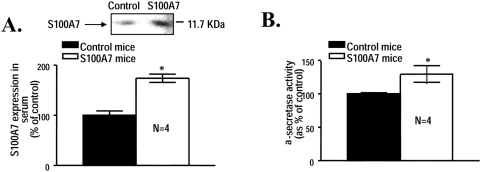
Elevated α-secretase activity in the brain of h-S100A7 transgenic mice.In this study, h-S100A7 transgenic mice were identified by dot blot hybridization of tail skin DNA samples with labeled h-S100A7 cDNA (for the h-S100A7 transgene). Expression of serum S100A7 (A) content in 1-month old h-S100A7 and age-, gender-, and stain-matched WT control mice was assessed by western blot analysis. The brains of h-S100A7 transgenic mice and WT control mice were assessed for α-secretase activity (B) using an activity assay kit (R&D Systems). Values represent mean±SEM and are expressed as percent of WT control mice group. *P<0.05, two-tailed Student t-test; n = 4 per group.